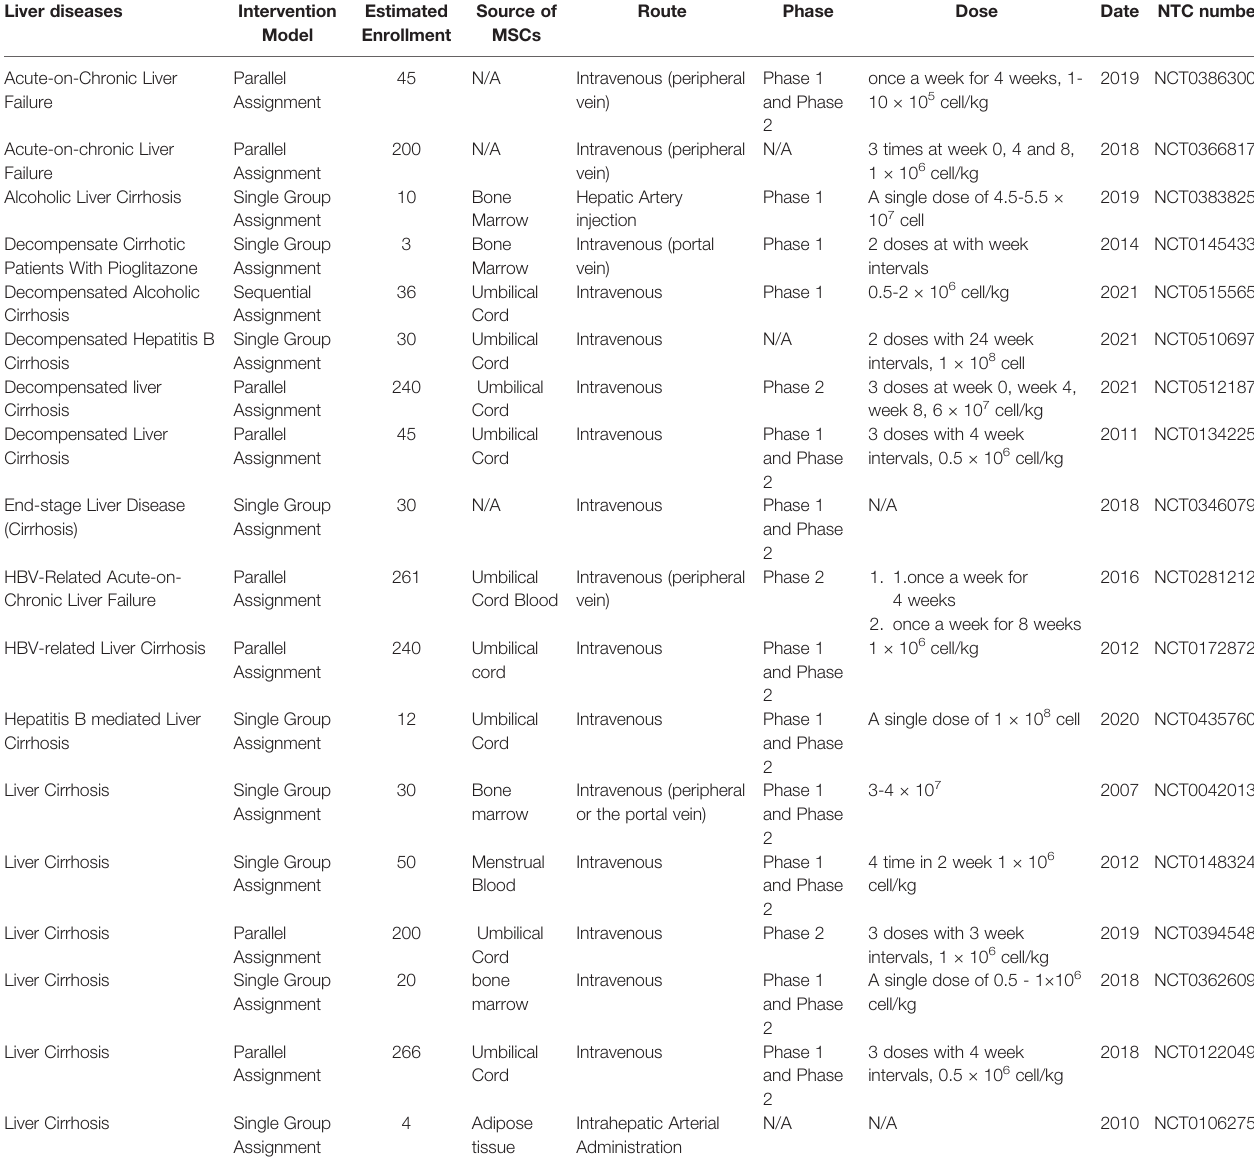
TABLE 3 | MSCs based clinical